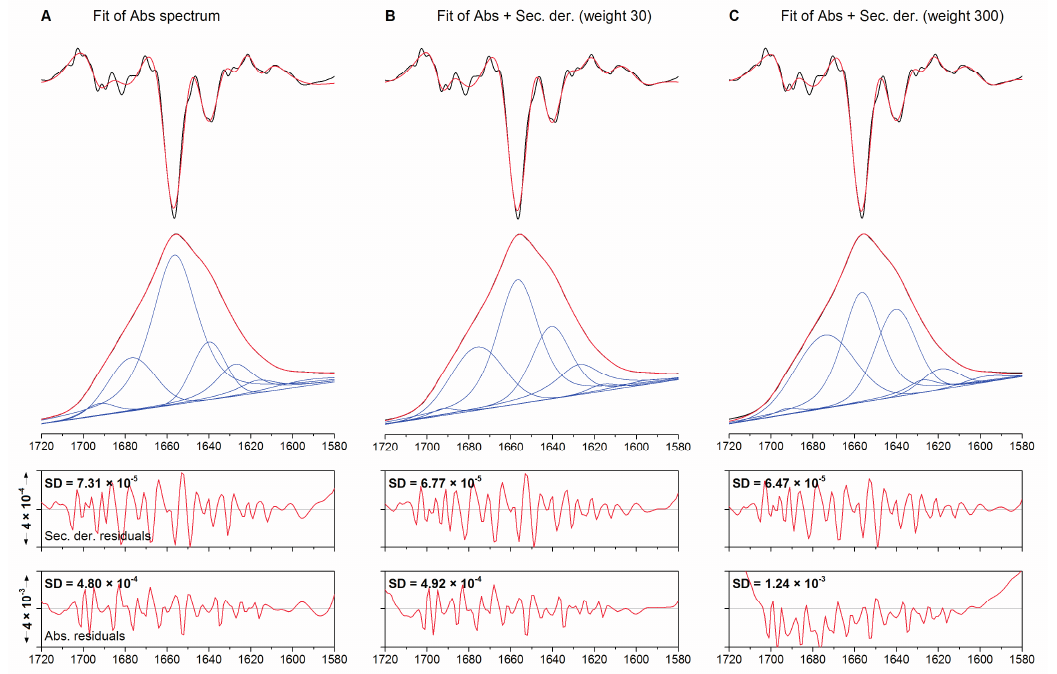
Figure 6. Fitting of the absorption spectrum of aconitase recorded without purging the spectrometer with dry air. ( A ) fitting of the absorption spectrum only; ( B , C ) simultaneous fitting of the absorption and second derivative spectra with weights of 30 and 300, respectively. From top to bottom: second derivative, absorption spectra and plots of the residuals. Original spectra are shown black, fitted spectra in red. The individual bands are shown in